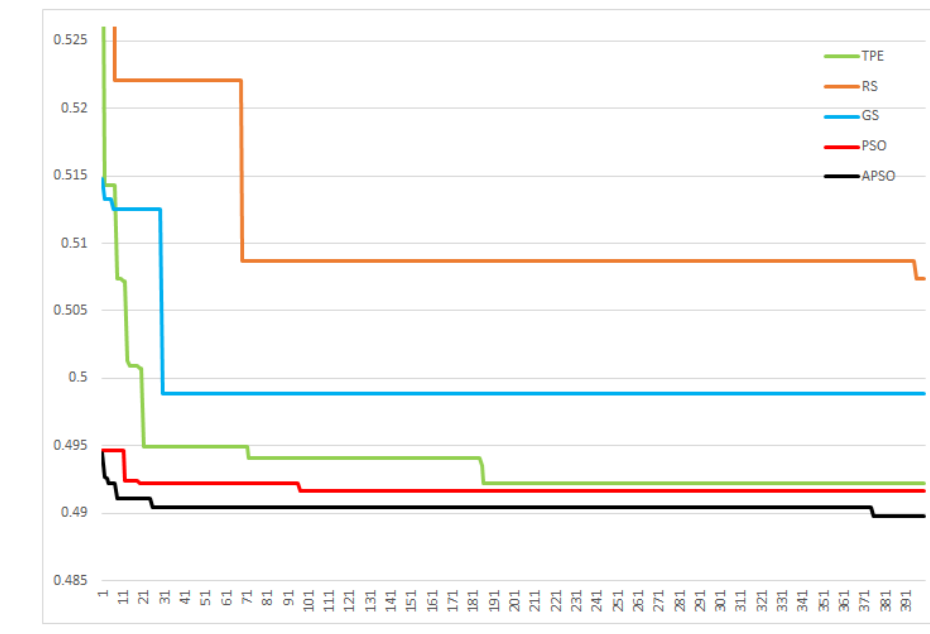
Figure 4. APSO-XGBoost credit scoring